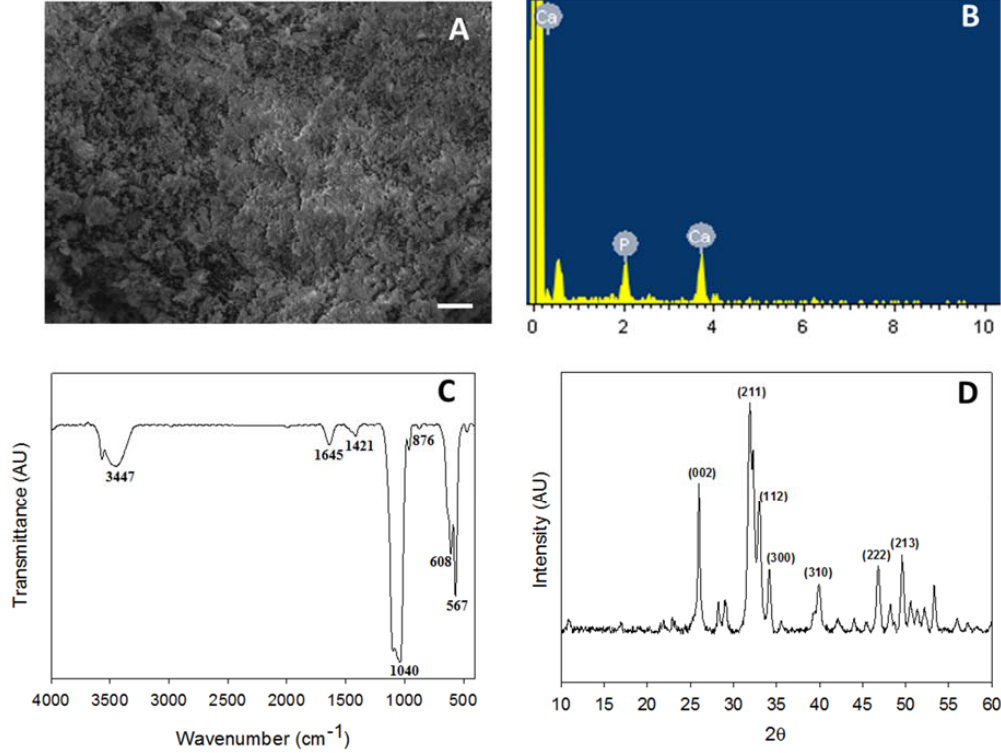
Figure 2. Characterization of nHAP by SEM (bar = 20 μ m) ( A ), EDS ( B ), FTIR ( C ) and XRD ( D ).